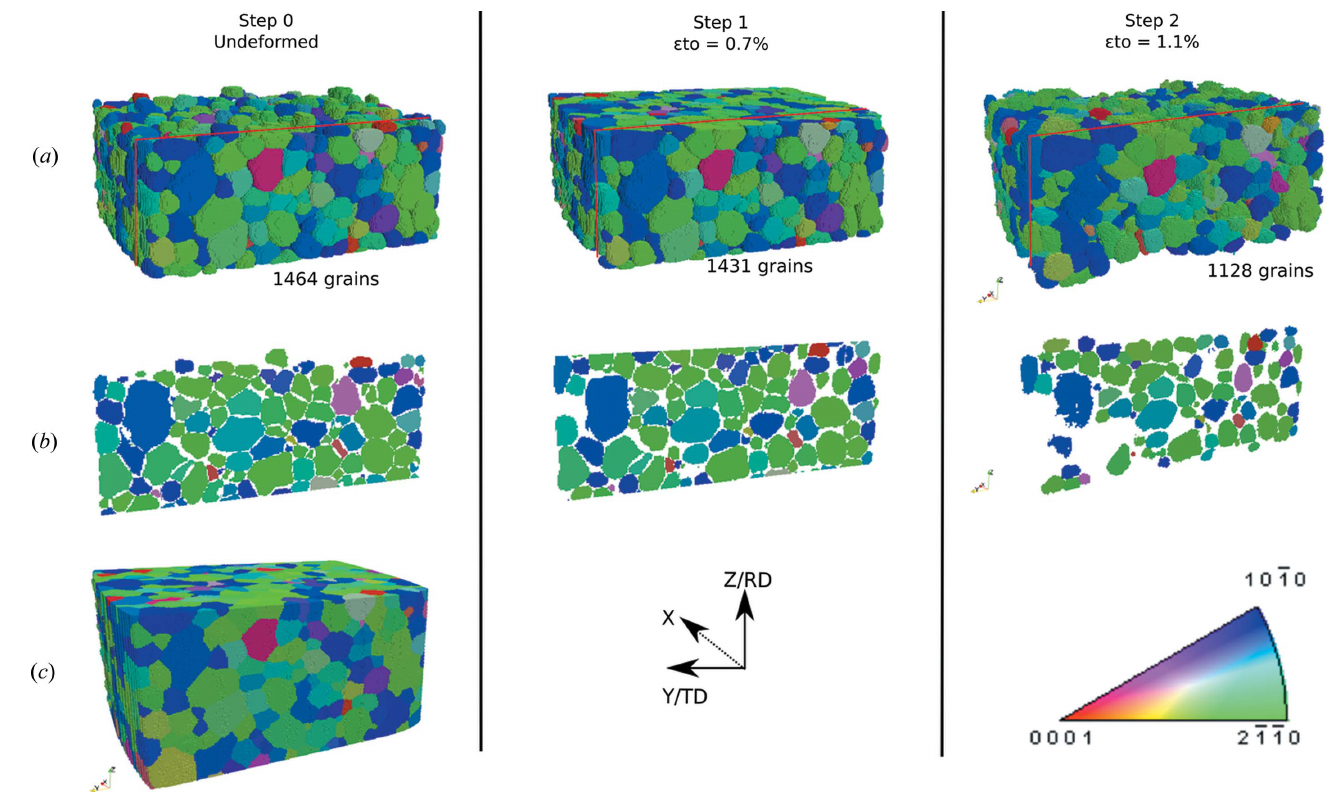
Figure 5 DCT reconstruction during in situ tensile test (IPF color coding along the tensile axis): ( a ) raw reconstructions of each loading step restricted to the common zone, ( b ) DCT slices corresponding to the repolished EBSD slice, ( c ) digital twin of the undeformed state after numerical cleaning and